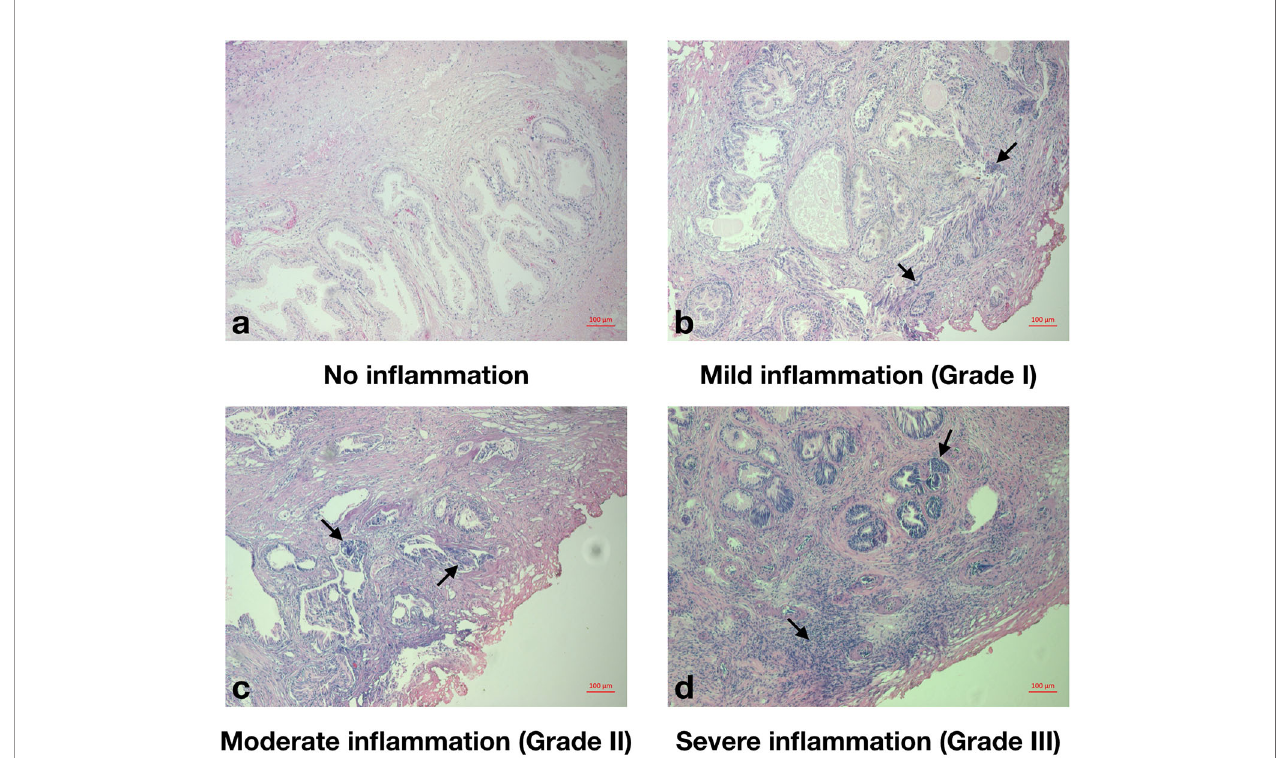
FIGURE 2 | Histopathological grade of prostatic in fl ammation. (A) , No prostatic in fl ammation. There was no in fl ammatory cell. (B) , Mild prostatic in fl ammation (Grade I). There were scattered in fl ammatory cells in fi ltrate within the stroma. (C) , Moderate prostatic in fl ammation (Grade II). There were non-con fl uent lymphoid nodules. (D) , Severe prostatic in fl ammation (Grade III). There were large in fl ammatory areas with con fl uence of in fi